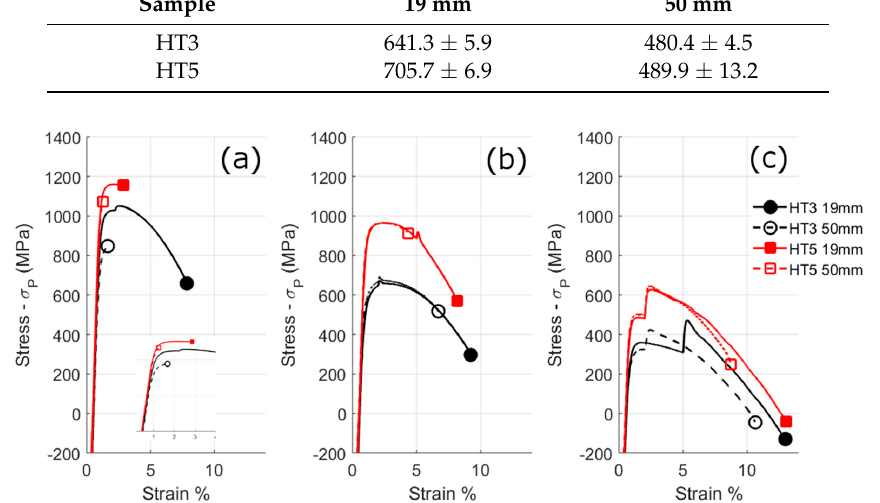
Figure 5. Tensile test stress-strain curves for HT3 and HT5 for the 19 mm and 50 mm bar sizes. σ P is the strengthening by precipitation of HT3. ( a ) at room-temperature; ( b ) at 200 °C; and ( c ) at 450 °C.